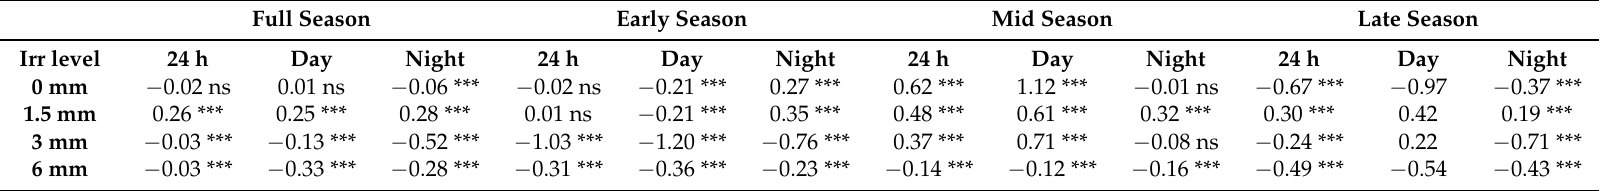
Table 2. Results of paired t -tests of canopy temperatures for okra and normal leaf varieties across seasonal periods at four irrigation